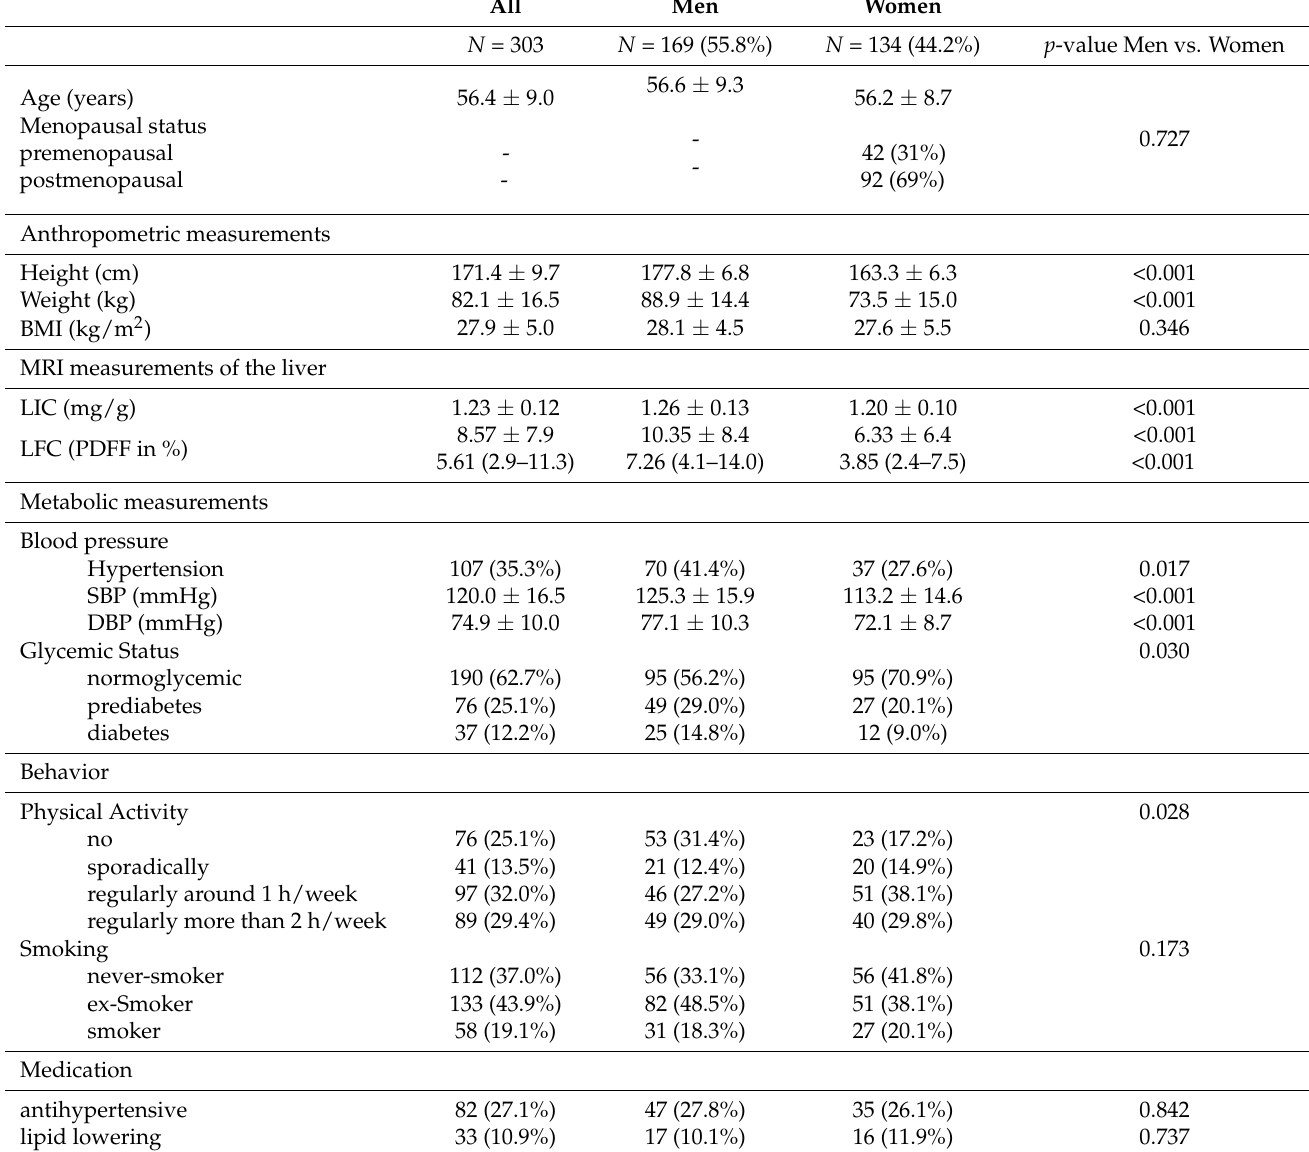
Table 1. Baseline characteristics of the study